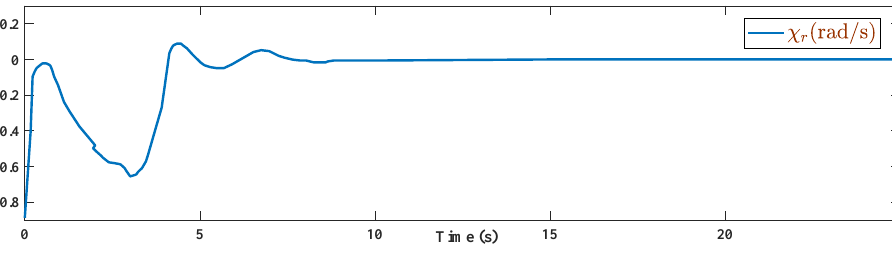
Figure 11. Time response of x r related to Scenario